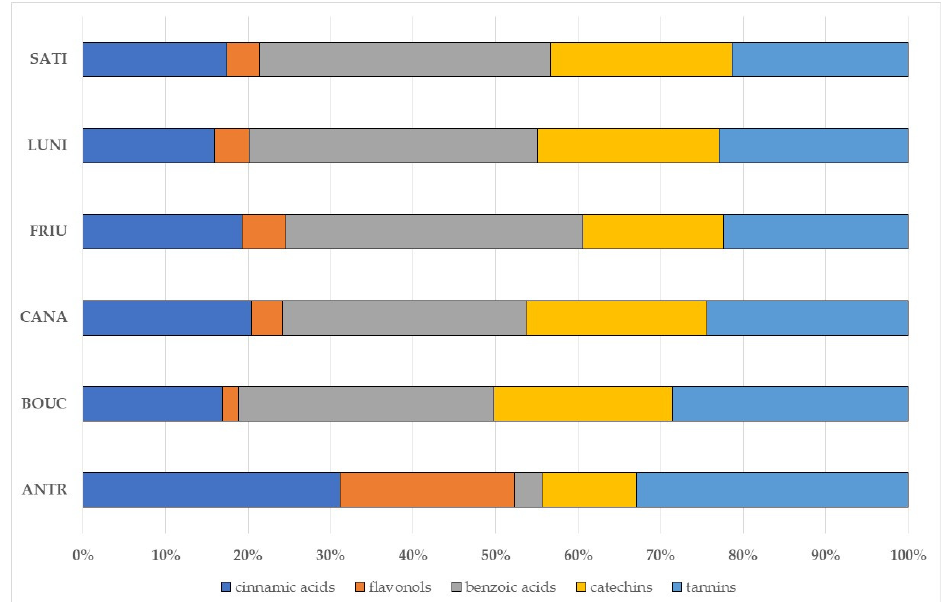
Figure 4. Polyphenolic profile of the analysed chestnut flours. Different colours highlighted the different phenolic classes. Blue: cinnamic acids; orange: flavonols; grey: benzoic acids; yellow: catechins; sky blue: